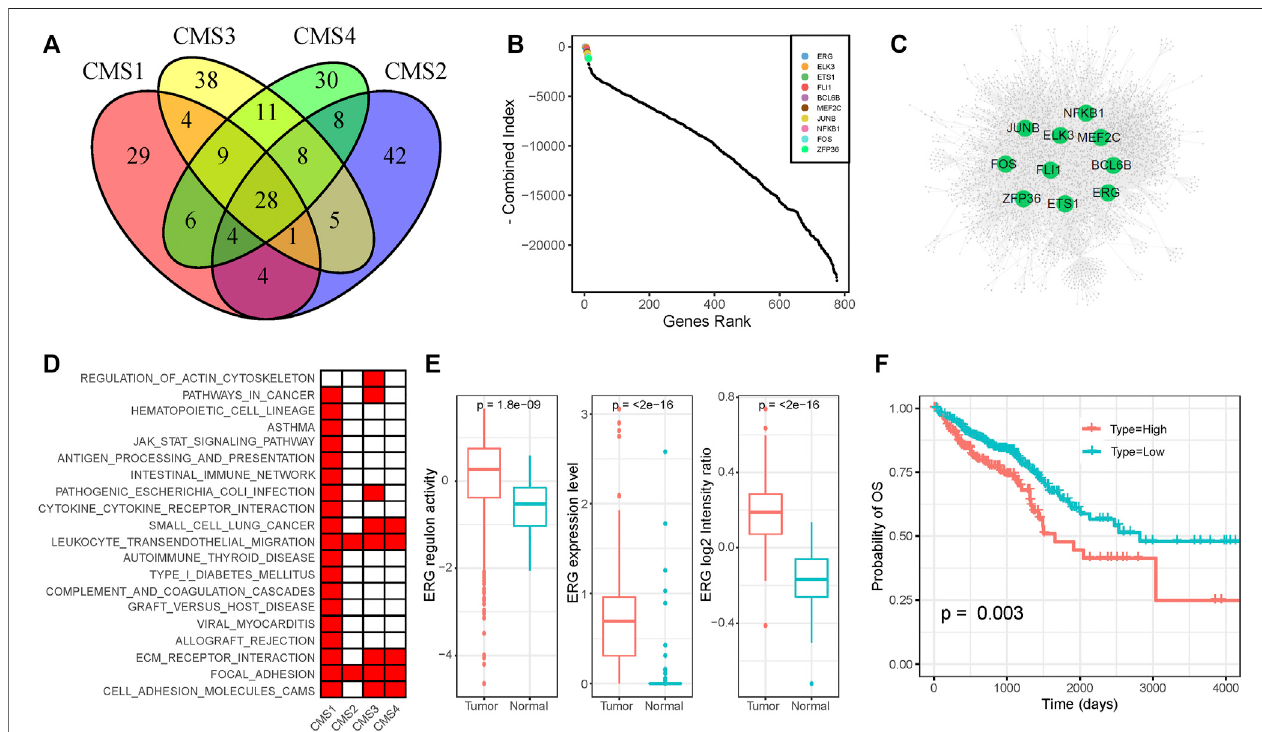
FIGURE 3 | Functional diversity of ERG (A) Venn plot of functional TFs of the four CMS (B) The importance of TFs among all four subtypes (C) The gene regulation network of CRC samples (D) KEGG annotation of ERG-regulated genes in each subtype (E) Expression level and activity of ERG in normal samples and tumor samples (F) Survival analysis of CRC patients on the basis of ERG expression. Lower expression of ERG was associated with a better clinical outcome.